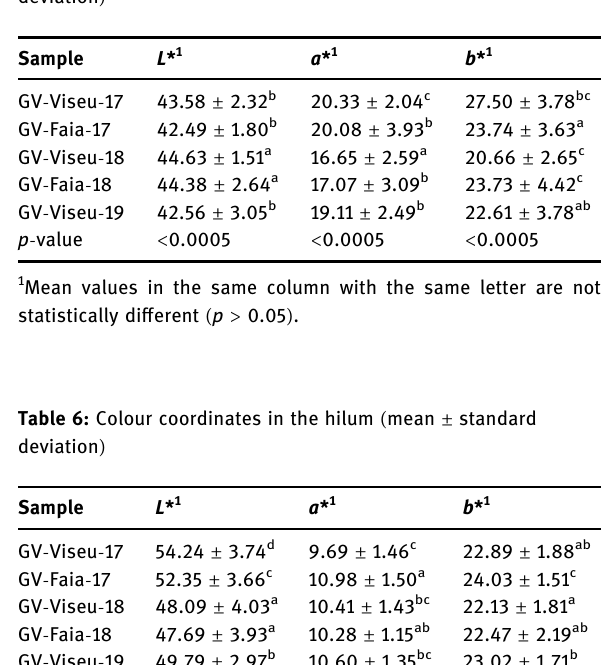
Table 5: Colour coordinates in the shell ( mean ± standard